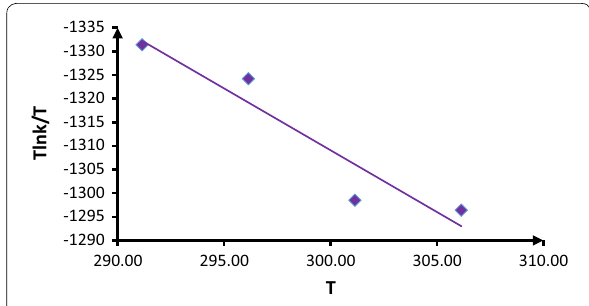
Fig. 8 A linearized form of Eyring Eq. 4 [Tlnk ovr /T against T] for the reaction between ( 1 ), ( 2 ) and ( N – H ) compounds in the